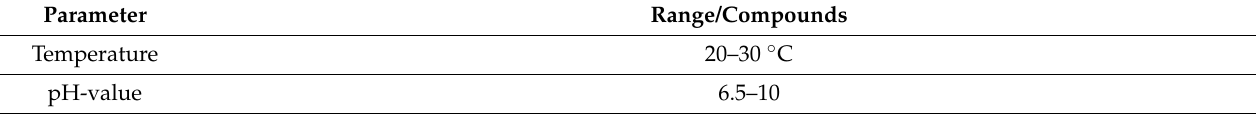
Table 3. Parameters tested for optimization of linoleic acid hydroperoxidation and safflower oil hydrolysis.